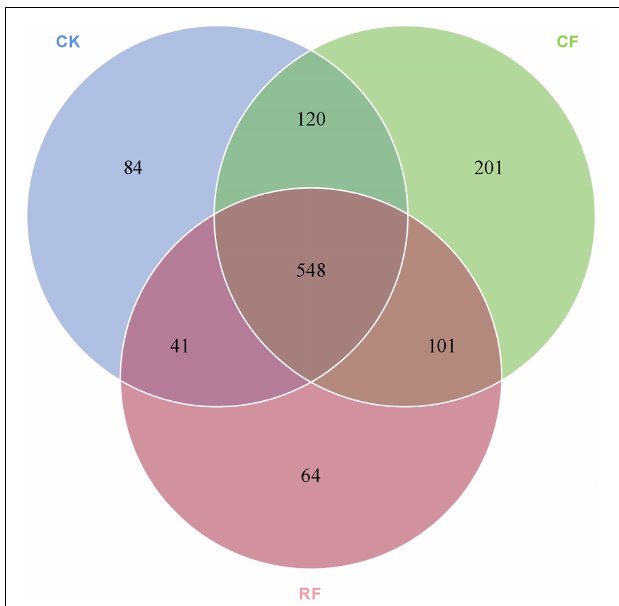
FIGURE 4 | Venn analysis of the number of common and unique operational taxonomic units (OTUs). CK, CF, and RF indicate without fertilizer applied, with compound fertilizer applied, and with reduced fertilizer applied,